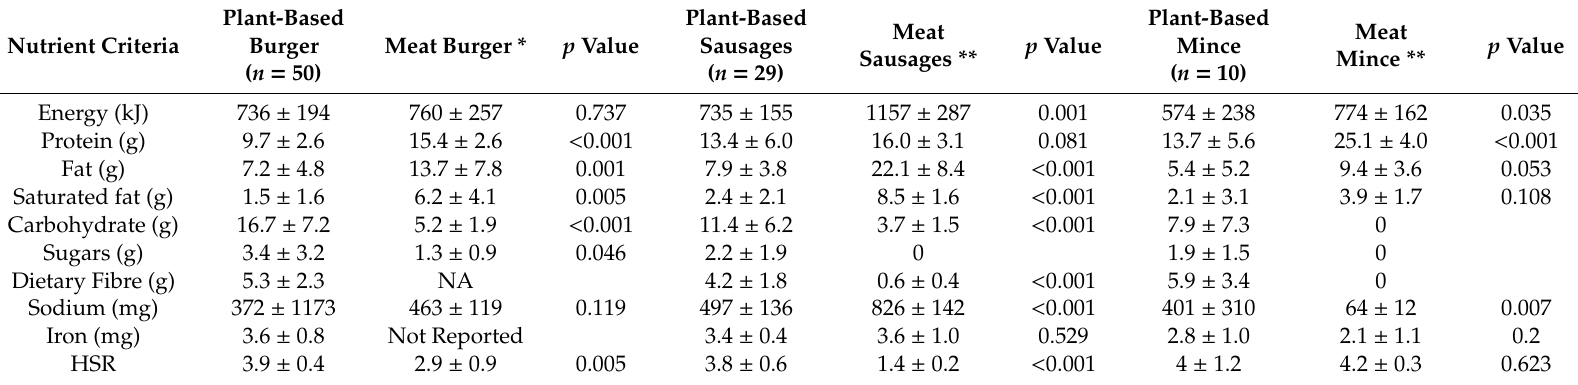
Table 4. Nutrients and Health Star Rating (HSR) / 100 g (mean and standard deviation) for plant-based and meat burgers, sausages and mince.